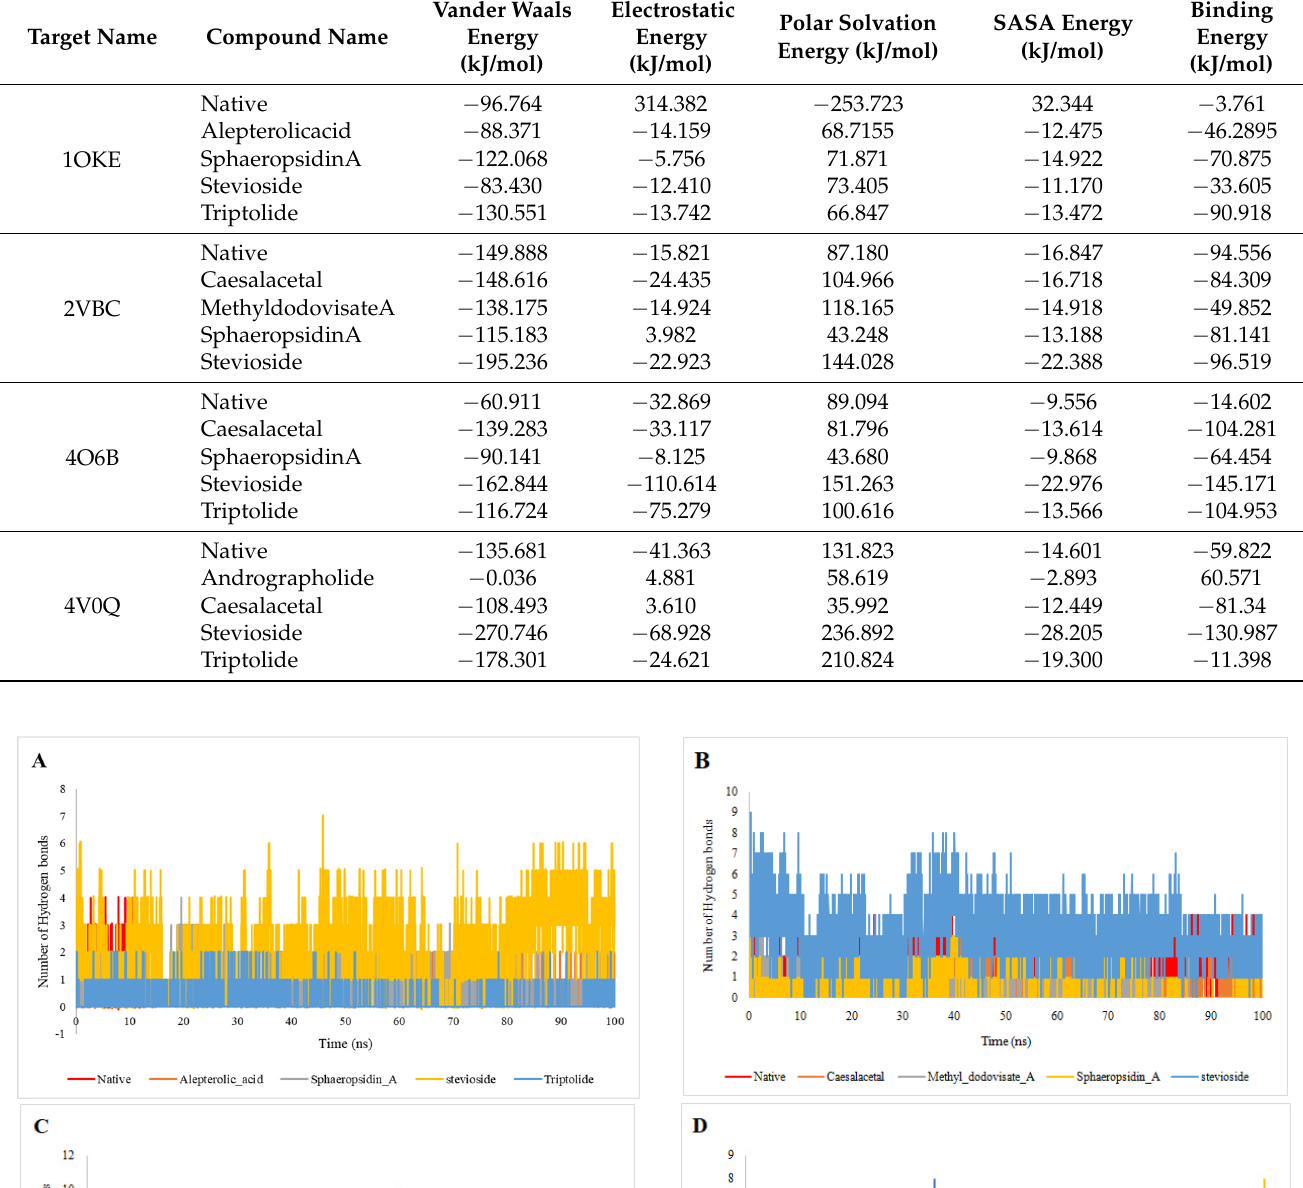
Table 7. Calculation of MMPBSA energy ( ∆ EMMPBSA) of the selected proteins and the nominated ligands.